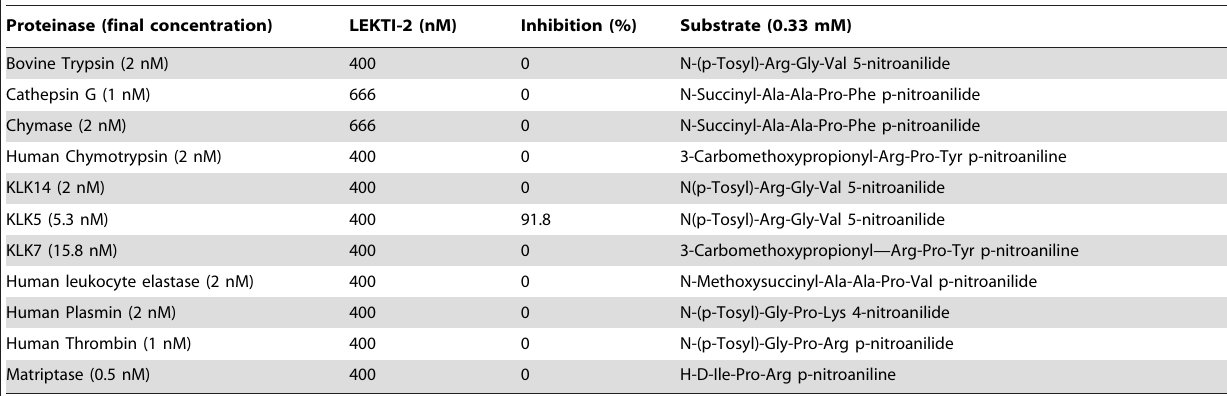
Proteinase (final